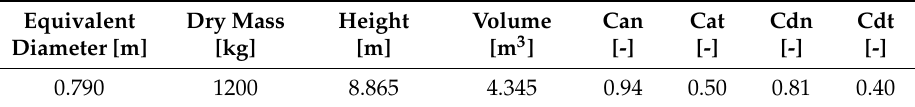
Table 5. Buoy properties.